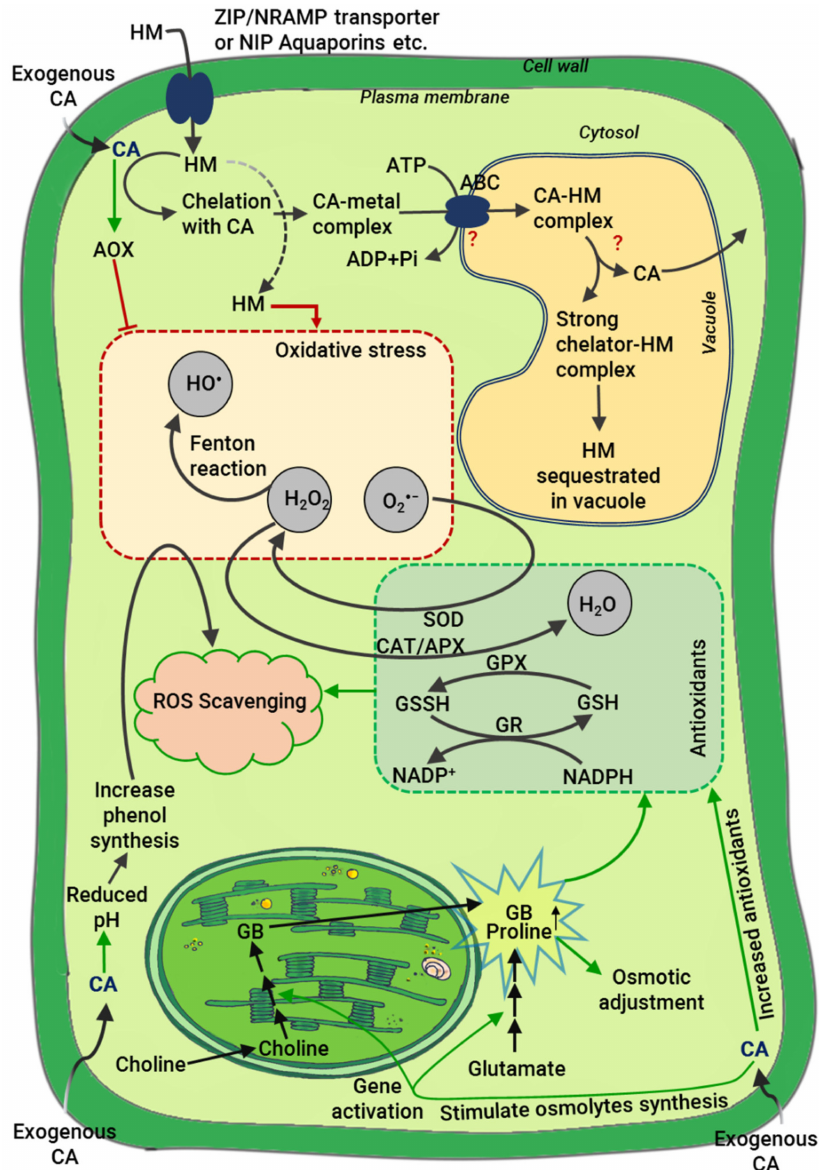
Figure 3. Overview of cellular mechanisms for HM detoxification and stress tolerance involving citric acid (CA). HMs enter cytosol after uptake through anion channels or metal transporters, for example, ZIP (zinc/iron -regulated transporter) family members or NRAMPs (macrophage proteins associated with natural resistance) family members or NIP aquaporin (nodulin-26-like intrinsic proteins of the aquaporin family) etc. Cellular CA functions as high-affinity ligand, chelating HMs in the cytosol and then binding together to form a stable chelation complex via the cytosol ligand exchange reaction. The chelation complex is then transported into the vacuole via vacuolar transporters like ABC (ATP-binding cassette) tonoplast transporter achieving HM sequestration. CA further aids vacuolar compartmentalization or remobilization of HMs by buffering the concentrations of cytosolic HMs, but the precise mechanism remains unclear. HMs induce oxidative stress in cells, leading to the formation of ROS. Exogenous CA enhances antioxidant systems (e.g., glutathione (GSH), superoxide dismutase (SOD), catalase (CAT), glutathione peroxidase (GPX), etc.) to fine-tune ROS levels and maintain normal cellular activities. High cellular CA also activates alternative oxidase (AOX) and that detoxifies ROS. Exogenous CA also induces osmolyte synthesis (e.g., proline, glycine betaine (GB), etc.) which regulates the osmotic balance and promotes ROS scavenging enzyme gene expression. Finally, CA decreases the pH of the cell and increases the synthesis of total polyphenol compounds (TPC) which directly scavenge